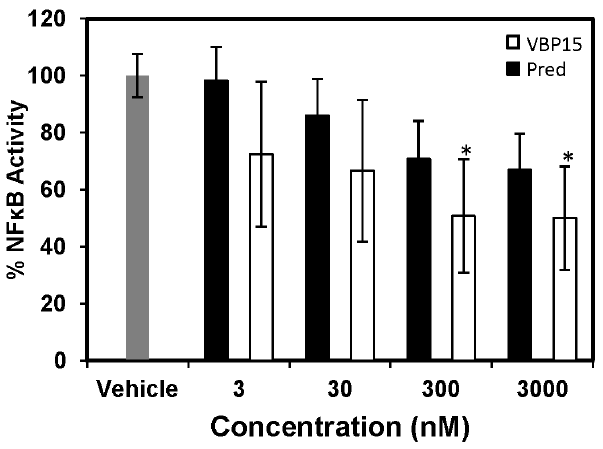
Figure 4. VBP15 inhibits NF k B activity. A549 cells stably- transfected with a luciferase NF k B construct were exposed to increasing concentrations of VBP15 or prednisolone (3, 30, 300, 3000 nM) followed by TNF a stimulation before measuring luciferase activity. Bar graph represents mean ( 6 SE) luciferase units. * p , .012 (due to the Bonferroni adjustment for multiple comparisons) compared to treatment with vehicle control. Data represents 4 biological replicates with assay performed in triplicate.